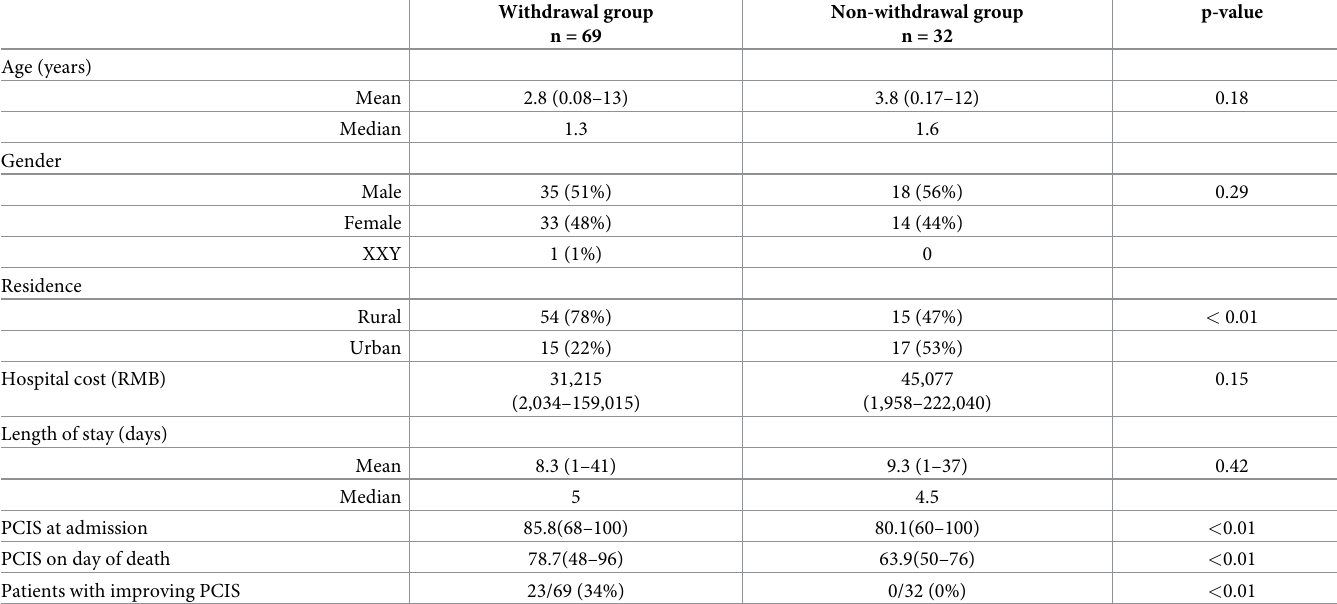
Table 2. Demographics and PCIS.